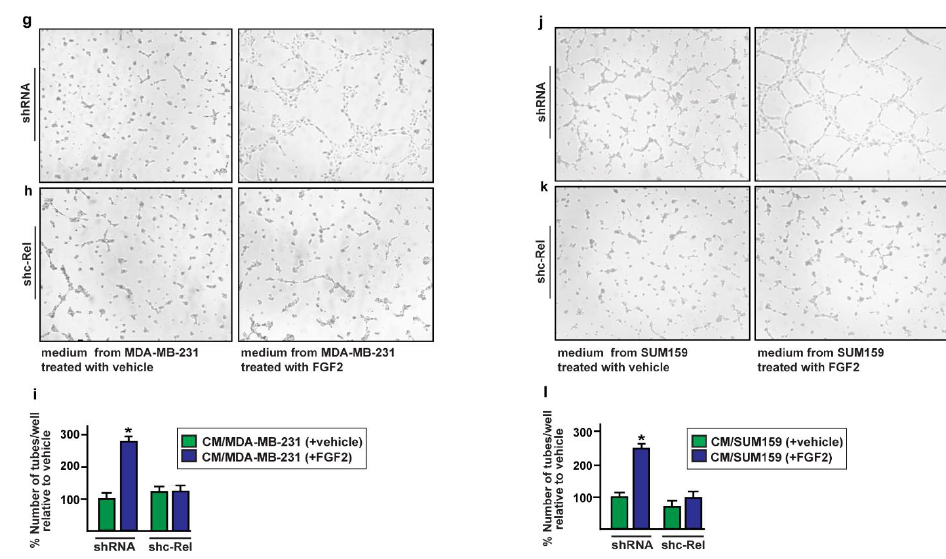
Figure 7. Conditioned medium (CM) from FGF2-stimulated MDA-MB-231 and SUM159 cells triggers endothelial tube formation. ( a , b , d , e ) Tube formation evaluated in HUVECs cultured for 6 h in CM collected from FGFR1 (WT) and FGFR1 (KO) MDA-MB-231 and SUM159 cells treated for 8 h with vehicle and 25 nM FGF2. Tube formation in HUVECs cultured for 6 h in CM collected from MDA-MB-231 and SUM159 cells transfected with shRNA ( g , h ) or shc-Rel ( j , k ) and then treated for 8 h with vehicle and 25 nM FGF2. ( c , f , i , l ) Quantification of the number of tubes observed in HUVECs, as indicated. Data are representative of three independent experiments performed in triplicate. (*) indicates p < 0.05.